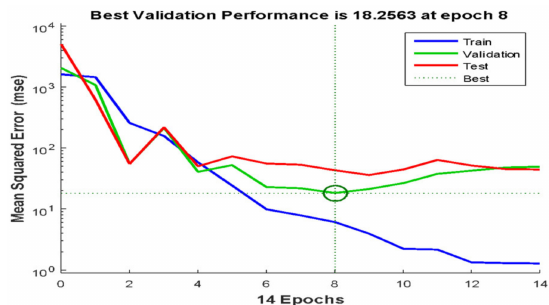
Figure 17. Network training cycles in site 3.